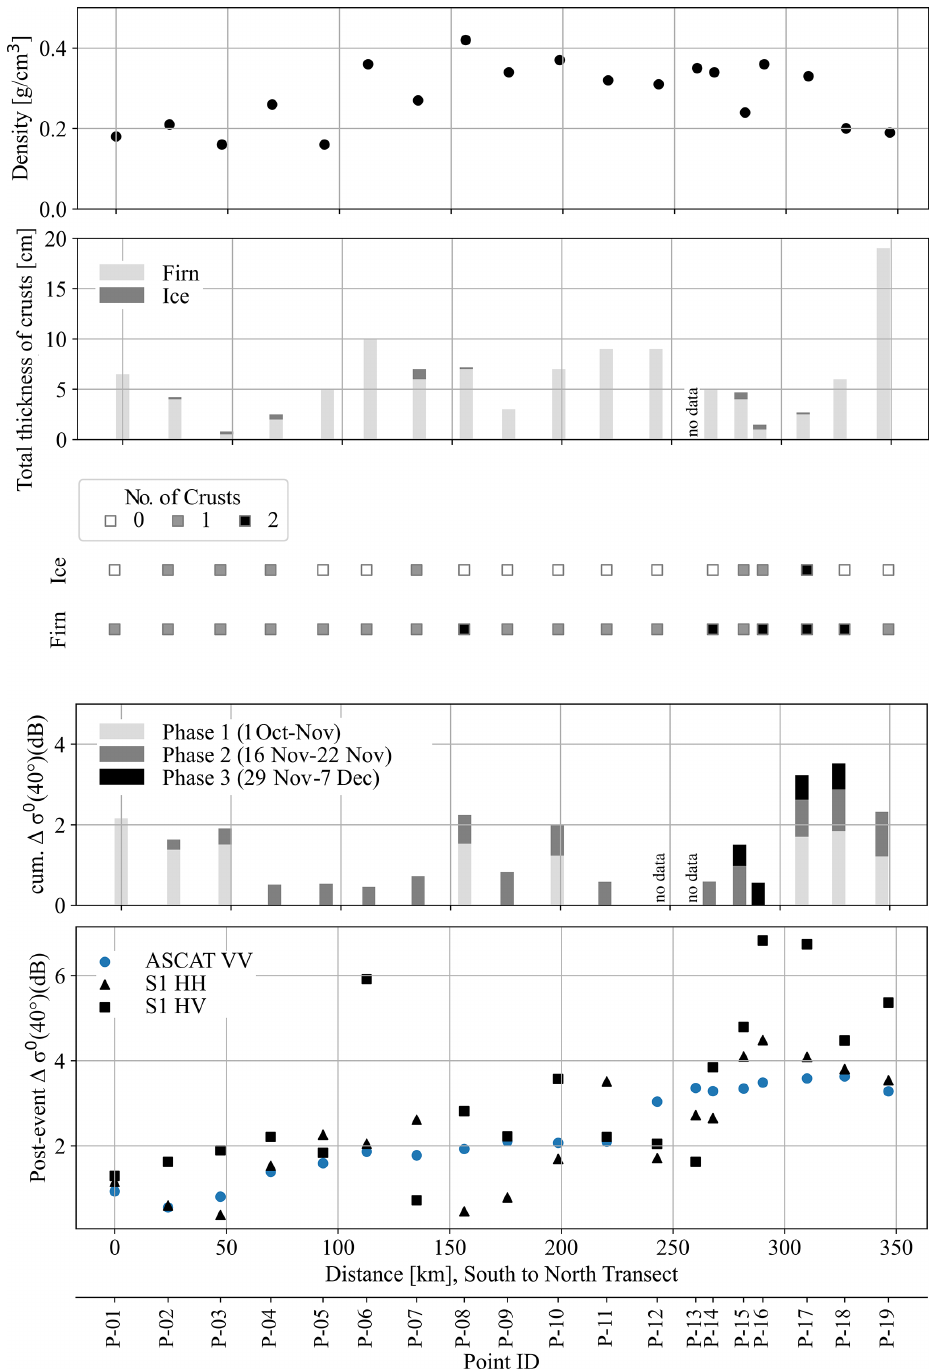
Figure 14. Documentation of snow conditions after the ROS events across Yamal at the end of 2020, including in situ measurements obtained in February 2021, ASCAT (cid:49)σ 0 along the in situ transect by event (difference before and after), and (cid:49)σ 0 from ASCAT and Sentinel-1 during the week after the last event (increase since November). For location of points see Fig. 5. No event data are available for coastal points 12 and 13 due to SMOS data